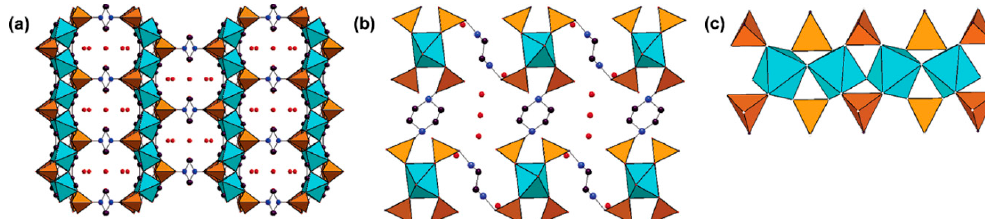
Figure 12. Crystal structure of MIL-91 viewed ( a ) along the c -axis and ( b ) the b -axis. For clarity, only one set of the two symmetry-equivalent (but half-occupied) sets of diphosphonate ligands connecting octahedral chains along c are shown. ( c ) A corner-sharing chain of MO 6 octahedra (c). Colour code: titanium: cyan, phosphorus: orange, oxygen: red, nitrogen: blue, carbon: purple. Adapted with permission from reference [67]. Copyright 2006, American Chemical Society.